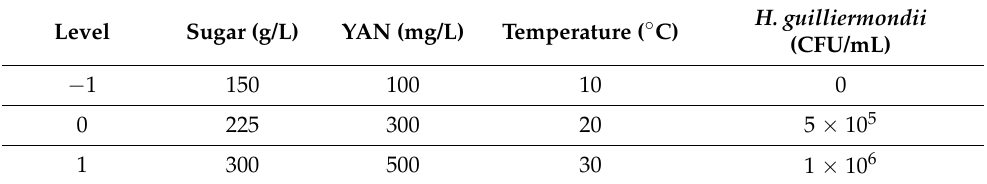
Table 1. Factor ranges and levels considered in the experimental design (CCD), expressed both in terms of coded and original